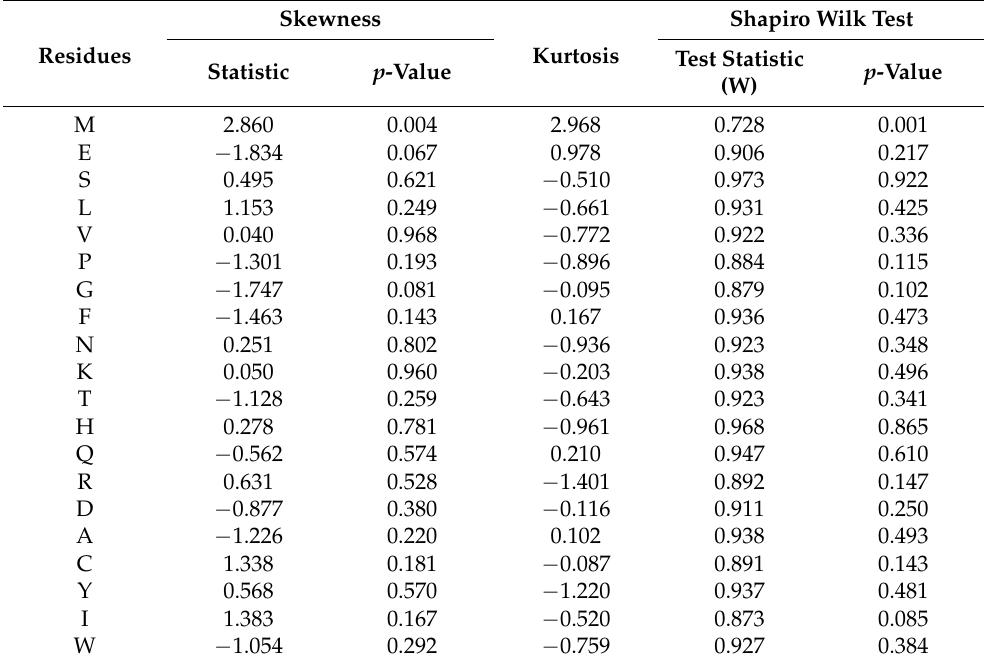
[Table 4]. Valine (W = 0.922, p -value = 0.336) and lysine (W = 0.938, p -value = 0.496) had the least skewness of 0.040 and 0.050, respectively (Table 4). Table 4. Test for normality for the amino acid compositions using Shapiro-Wilk test, skewness and kurtosis. The values presented are rounded to 3 decimal